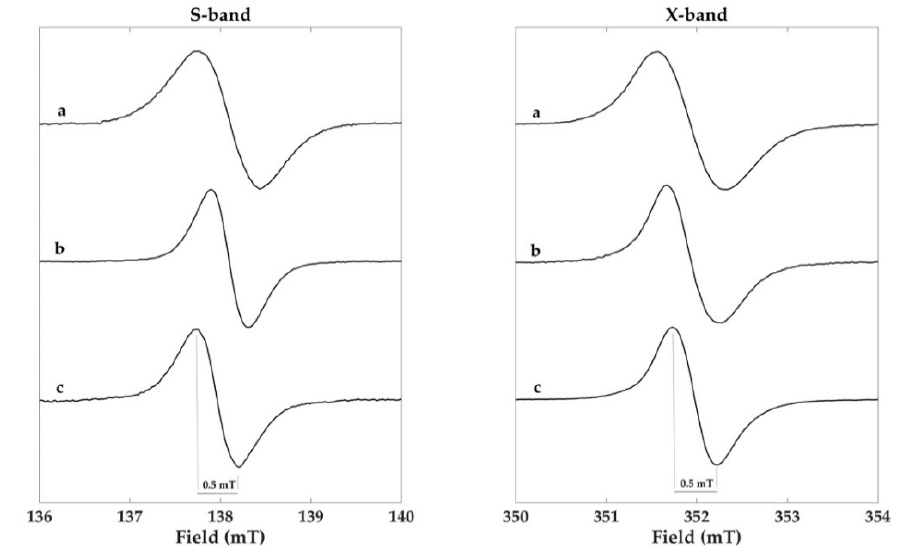
Figure 4. S- (3.9 GHz) and X-band (9.8 GHz) EPR spectra of the ( a ) Sc-Ms1 natural melanin, ( b ) Sc-Ms1 tyrosinase dopa-melanin, and ( c ) Tv laccase dopa-melanin samples. Spectra were recorded at 1.90 mW microwave power at S-band and 1.46 mW at X-band. Spline functions were used for the baseline correction of the S-band